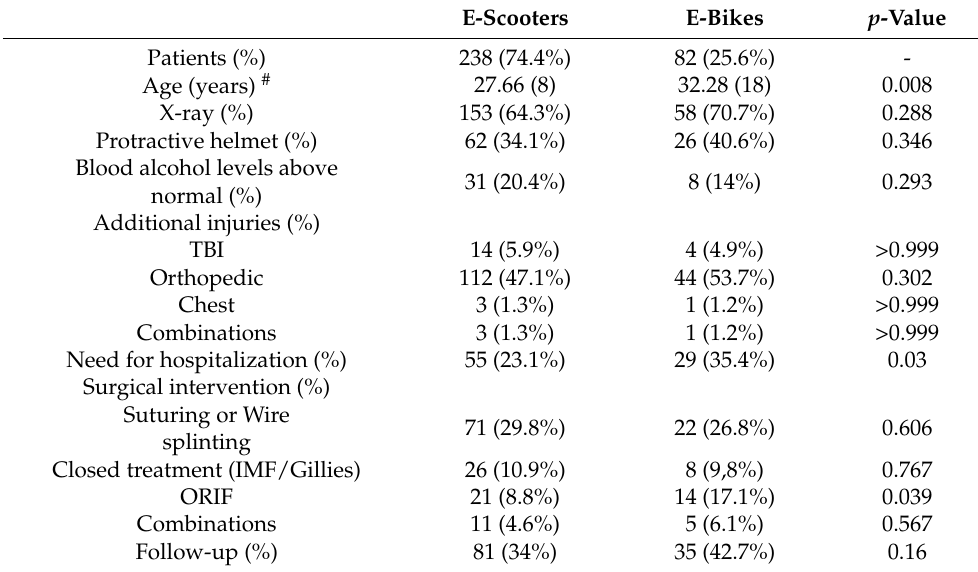
Table 1. Differences between E-bikes and E-scooters riders (n = 320